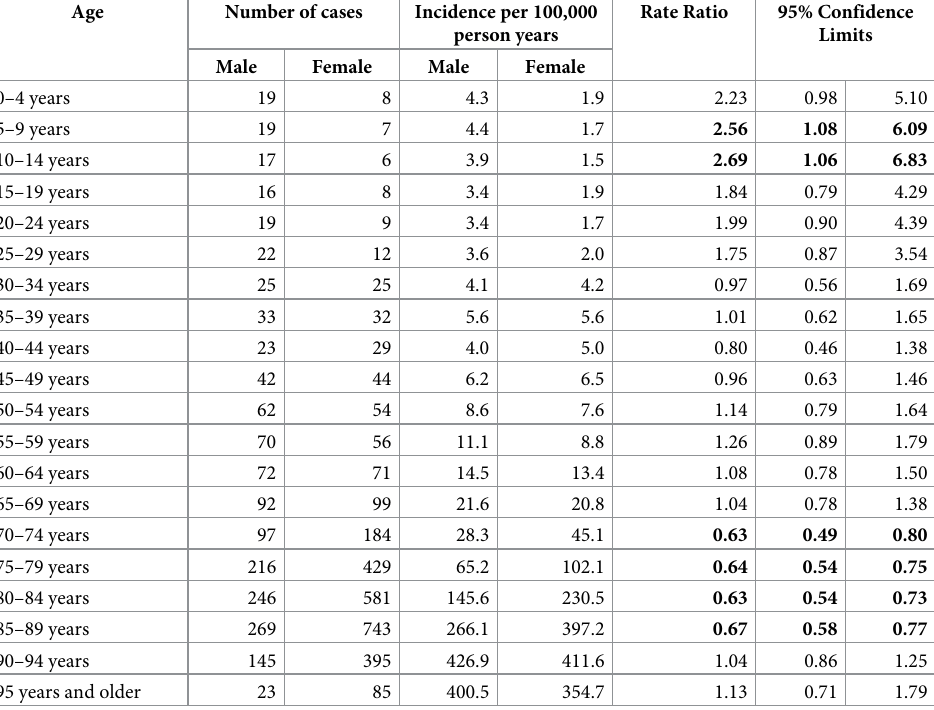
Table 1. Age- and sex-specific incidences per 100,000 person-years among all patients who requested a health care allowance in 2017 and 2018 in Austria because of a diagnosis-related minimum classification of visual impairment, blindness and deaf-blindness (source of reference population: STATISTIK AUSTRIA, https://www. statistik.at/web_de/statistiken/menschen_und_gesellschaft/bevoelkerung/index.html, accessed May 17 th , 2018) (bold values: Statistically significant results). Age